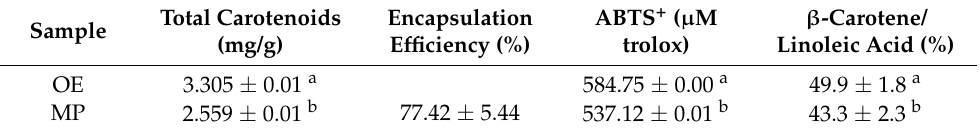
Table 1. Total carotenoids, encapsulation efficiency and antioxidant activity in the oil extract (OE) and microparticle (MP)